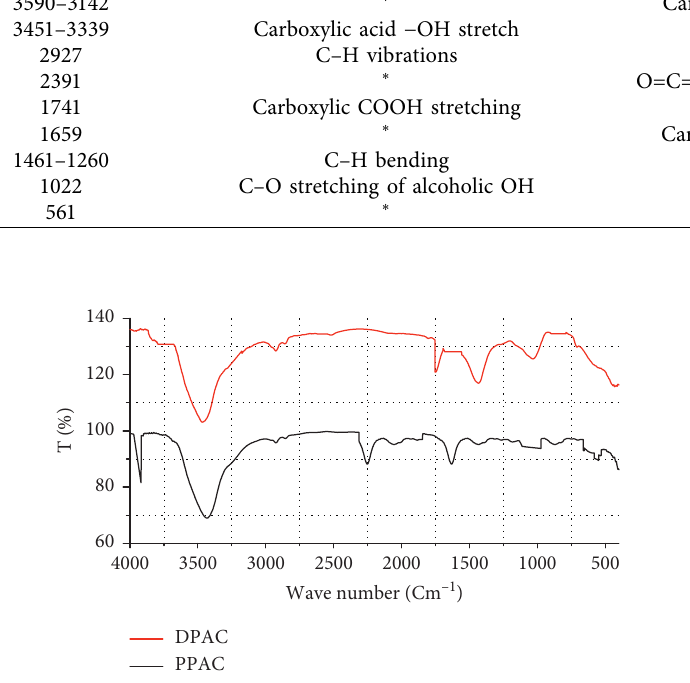
Figure 3: FTIR spectrum of adsorbents: DPAC (red line) and PPAC (black line). Table 2: The specific surface areas, radii, and pore volumes obtained for DPAC and PPAC.